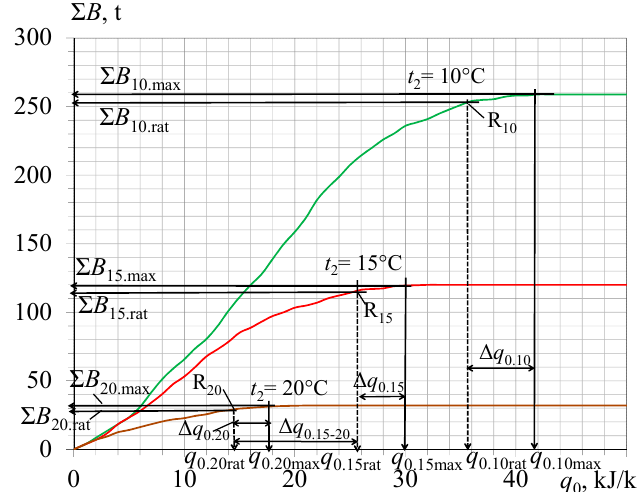
Figure 11. Annual fuel reduction Σ B e versus specific design cooling capacity q 0 for cooling ambient air to t a 2 = 10, 15, and 20 °C: Σ B 10;15;20 —for t a2 = 10, 15, 20 °C; Δ q 0.10,15,20 = q 0.10,15,20max − q 0.10,15,20rat ; points R 10,15,20 —rational values of q 0.10,15,20rat and Σ B 10,15,20rat